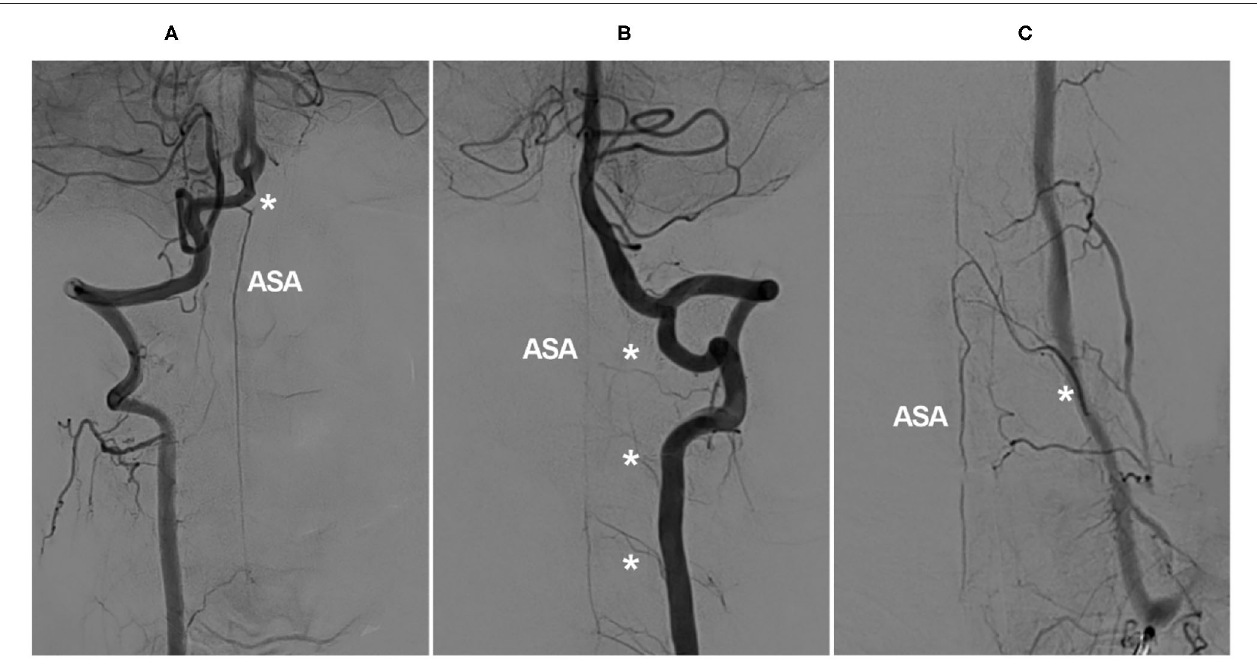
FIGURE 1 | Angiographic cervical ASA anatomy. (A) VA angiogram showing a long-distance ASA arising from intracranial VA termination (asterisk). (B) VA angiogram showing that the ASA is relayed by the continuous segmental radiculomedullary arteries (asterisks). (C) VA angiogram showing the artery of cervical enlargement (asterisk). ASA, anterior spinal artery; VA, vertebral artery.